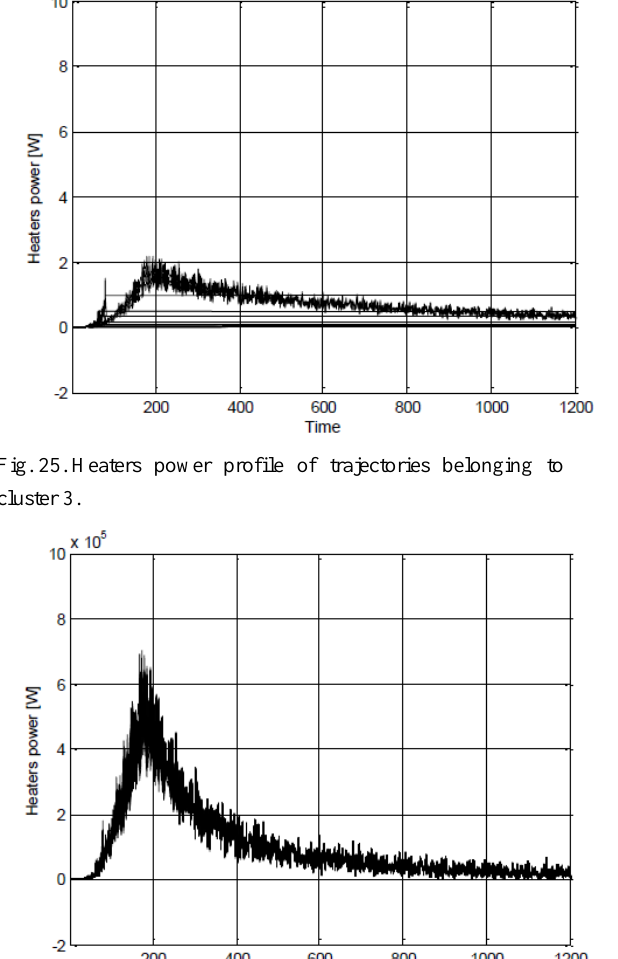
Table 4. Performance of the clustering approach